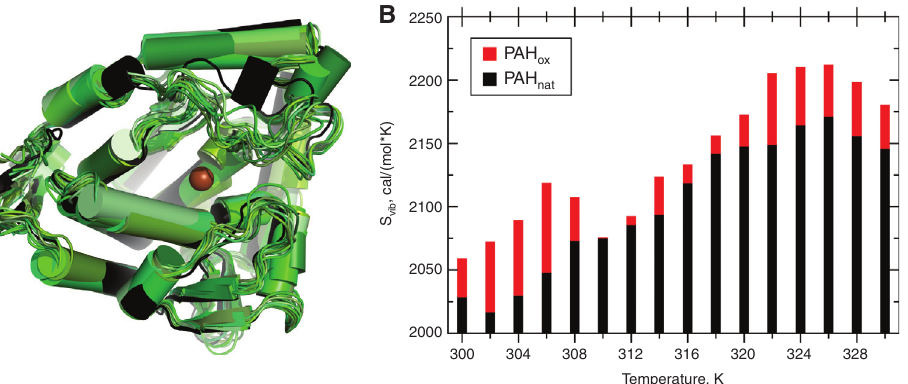
Figure 2 (A) Structural ensemble of 10 snapshots extracted from a 200-ns MD simulation of oxidized PAH [66]: The catalytic domain of PAH is shown as a cartoon with the catalytic iron ion as a brown sphere. The X-ray structure is shown in black; accessible structures in the MD ensemble in different shades of green show the diversity of the adopted conformations. Solution dynamics of the highly flexible Tyr-138 can be seen on the top right including the discussed contraction over the active site. (B) Conformational entropy of native and oxidized PAH [66]: Conformational entropy was calculated from 16 parallel replica exchange molecular dynamics simulations for both systems. Entropy values are shown as black bars for the native state and as red bars for the oxidized state. Conformational entropy of the oxidized state exceeds the entropy of the native state at each temperature-equivalent simulation, indicating an unexpected mobilization by the introduc- tion of an additional